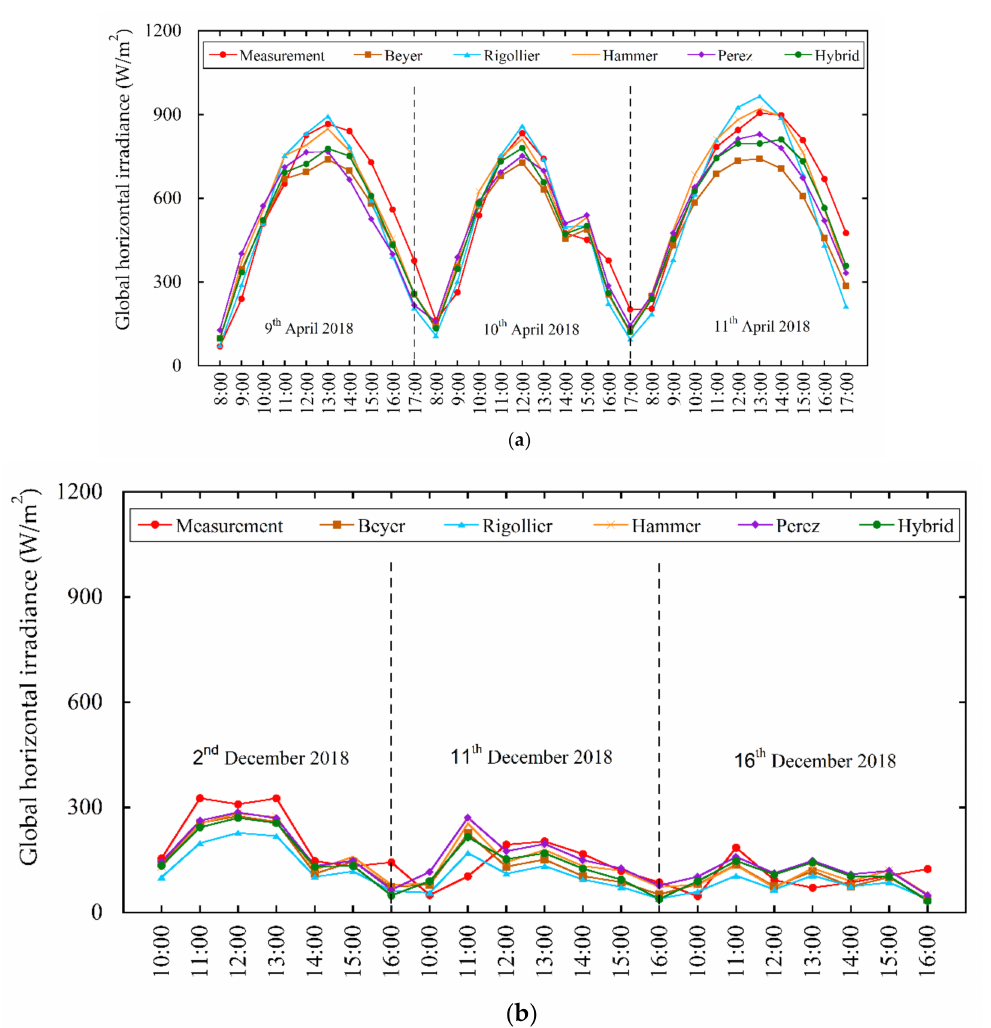
Figure 7. Daily variations of solar irradiance: ( a ) clear sky conditions and ( b ) overcast